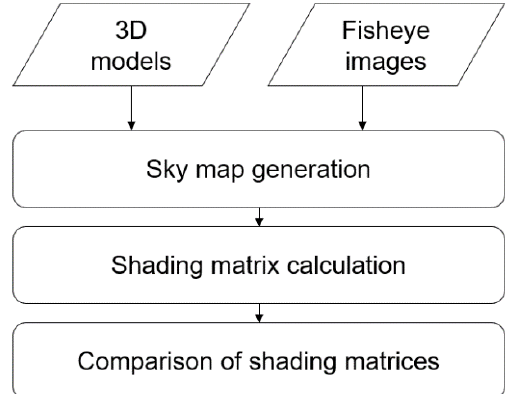
Figure 1. Procedures of comparing shading matrices generated from 3D models and fisheye images.